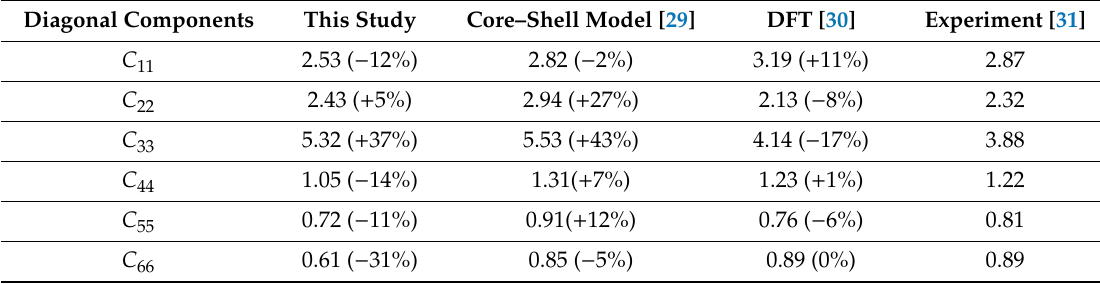
Table 3. Calculated and experimental diagonal components of the elastic tensors ( C ij units of Mbar) of Al 2 SiO 5 . Density functional theory is abbreviated as DFT.